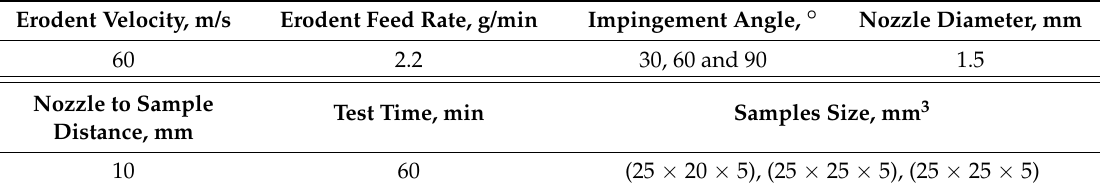
Table 2. Erosion test